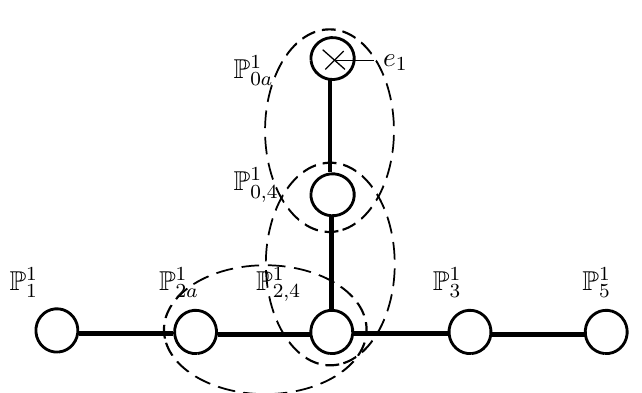
Figure 6 . Extended Dynkin diagram of E 6 at the d 5 = 0 locus. The a(cid:14)ne node intersects [ e 1 ]. The dashed ellipses indicate SO(10) nodes before the matter split. Two of the E 6 nodes occur in the split of two SO(10)